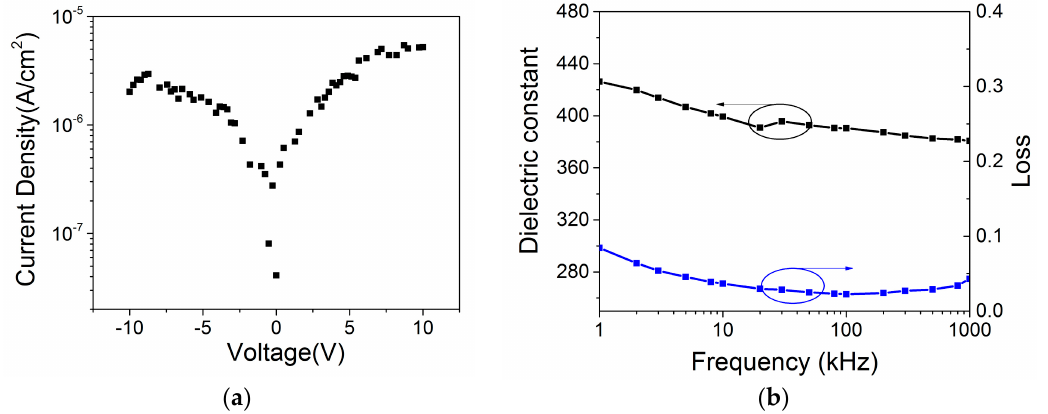
Figure 5. ( a ) Leakage current density vs. voltage (J-V ) curve, and ( b ) frequency dependent dielectric properties of the BiFeO 3 /BaTiO 3 bi-layer film.